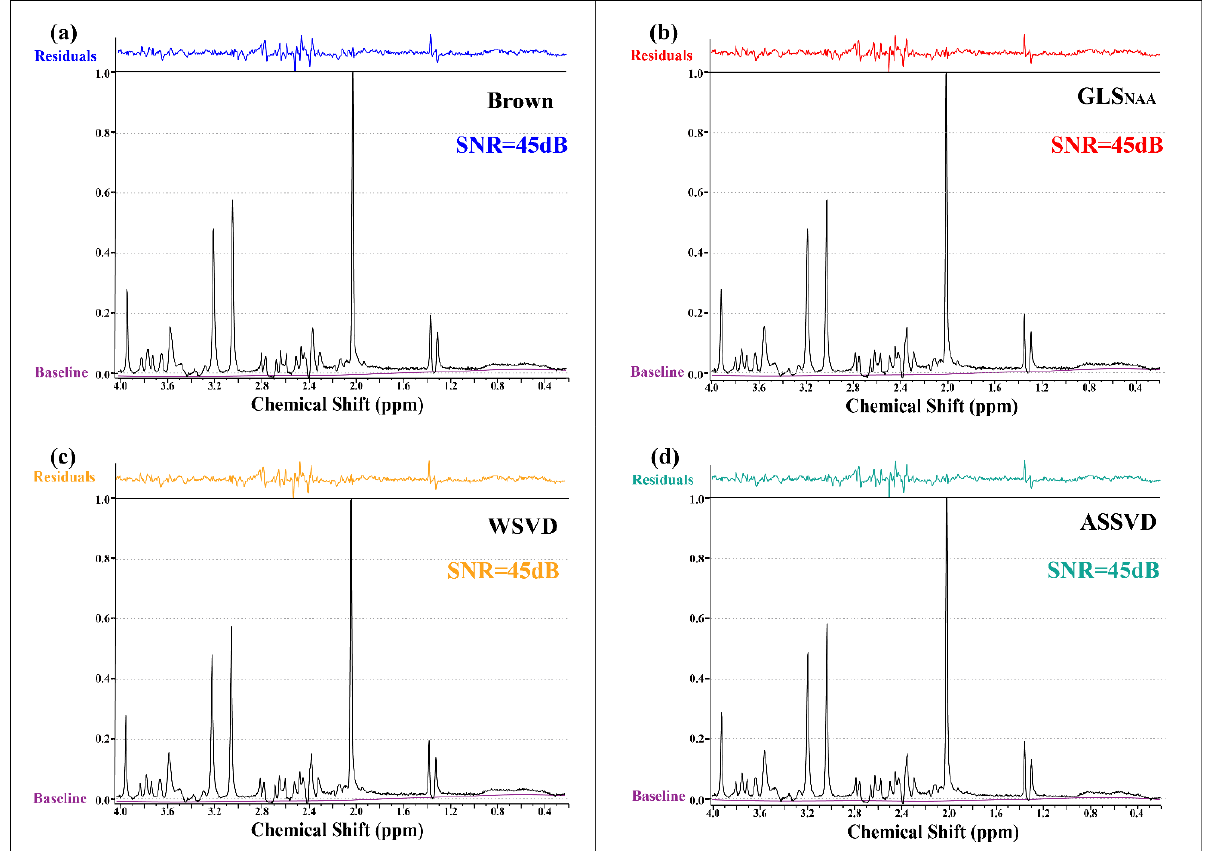
Figure 5. Phantom MRS coil-combined results. ( a ) Brown, ( b ) GLS using NAA peak as the reference, ( c ) WSVD, and ( d ) the proposed method ASSVD. The black and purple lines represent coil-combined MRS x and the spectral baseline x baseline estimated by LCModel, respectively. Additionally, the fitting residuals shown at the top were calculated by x − x baseline − x fitted Table 2. Absolute quantification concentration (AQC) (mmol/L) of the phantom